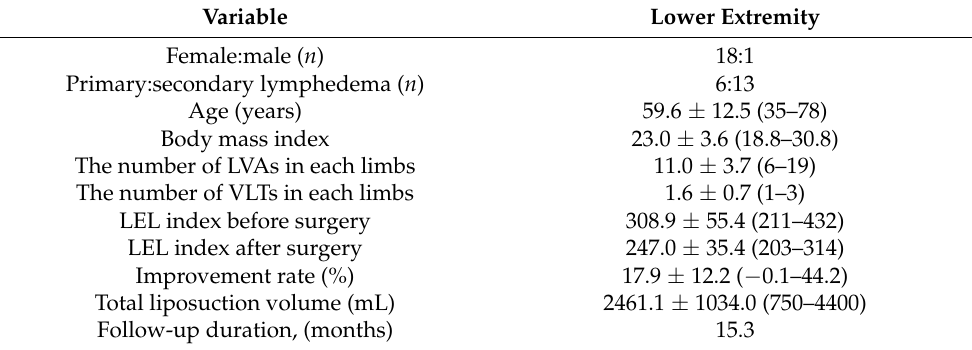
Table 1. LEL; Lower Extremity